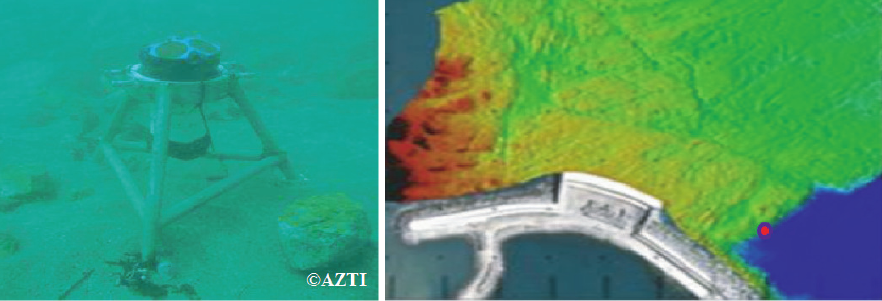
Figure 12. Acoustic Doppler Current Profiler in Mutriku.